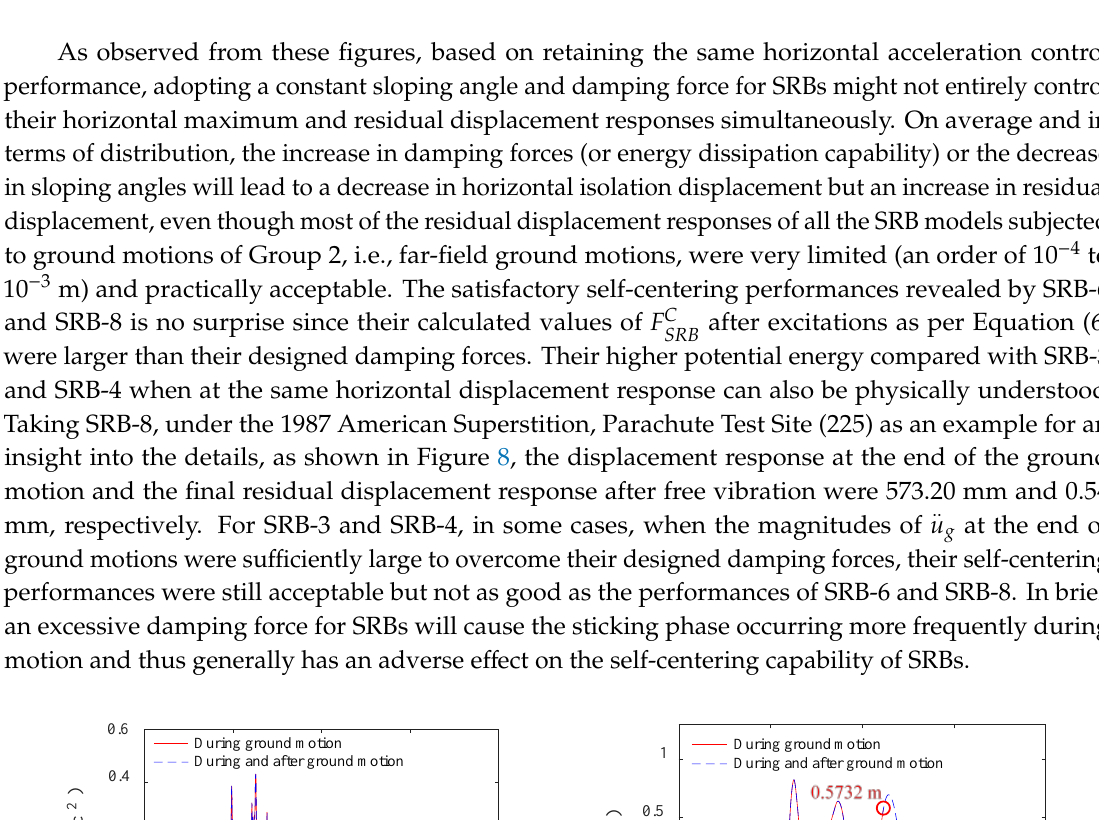
Figure 9. Idealized composition of analytical models for FPBs. 4.2. FPB Models To quantitatively and objectively discuss the potential advantages of FPBs and SRBs in diverse aspects, the seismic responses of SRB-3 and SRB-6, as detailed in Section 3.2, were referred by the design criteria for the FPB models first and then were compared with those of the FPB models designed. Ground motions of Groups 2 and 3, as detailed in Section 2 and listed in Table 1, were also employed herein. More precisely, first, the average of maximum horizontal displacement responses of each SRB model, respectively, subjected to ground motions of Groups 2 and 3 was considered as the design displacement ( D D ) i ( i = 2 and 3) for the FPB model, as given in Equation (8). At the design displacement, the FPB model had the same horizontal acceleration response as the SRB model, i.e.,